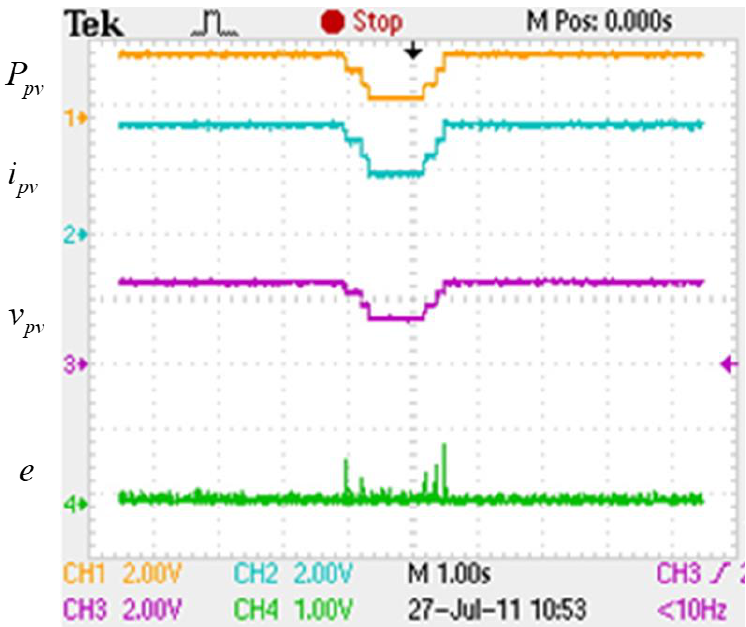
Figure 17. Output waveforms of PV array covered by a board and then